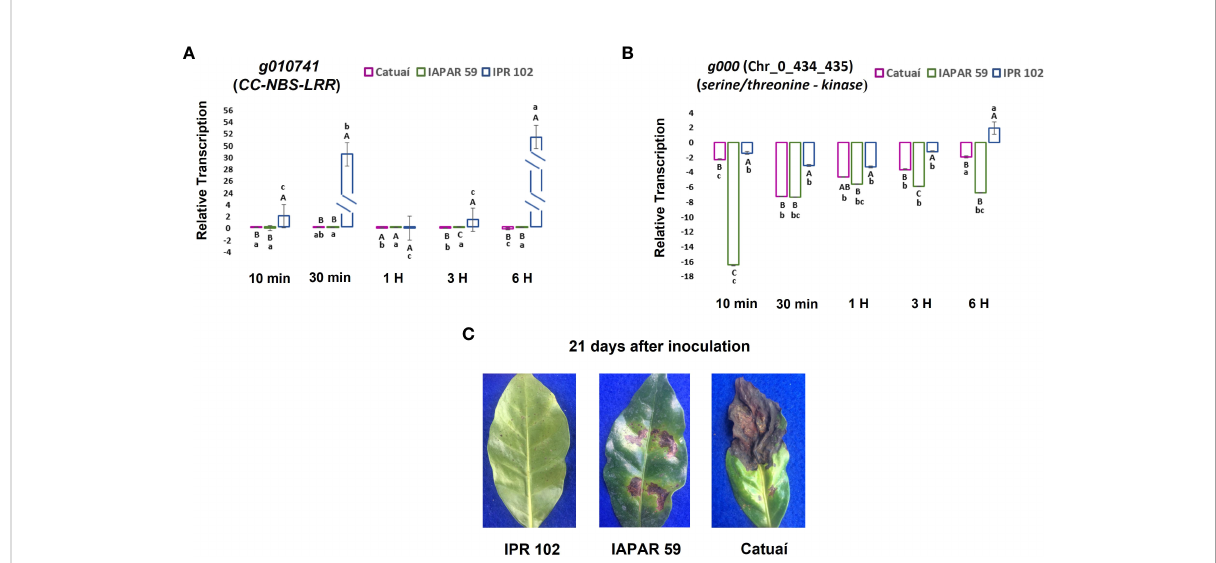
FIGURE 5 (A) Transcription levels of genes related to BHB resistance in leaves of C. arabica Catua ı ́ Vermelho IAC 99, IAPAR 59, and IPR 102 inoculated with P. syringae pv. garcae . (A) Serine/threonine- kinase g000 (Chr_0_434_435) and (B) CC-NBS-LRR g010741 (Chr_2_sg_E). Data represent means ± standard deviation. Upper case letters compare columns of different genotypes at the same tai and lower-case letters compare columns of the same genotype at different tai. Same letters show no difference by the Tukey test (for P ≤ 0.05). (C) Phenotypic analysis of IPR 102, IAPAR 59, and Catua ı ́ Vermelho IAC 99, 21 days after